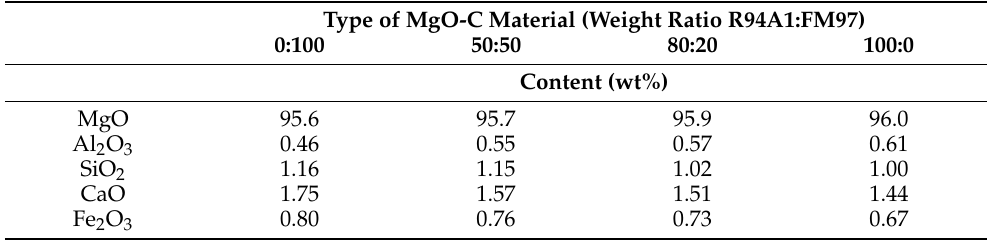
Table 3. Content of magnesia and the main impurities in the produced refractory materials analyzed after carbon burnout.